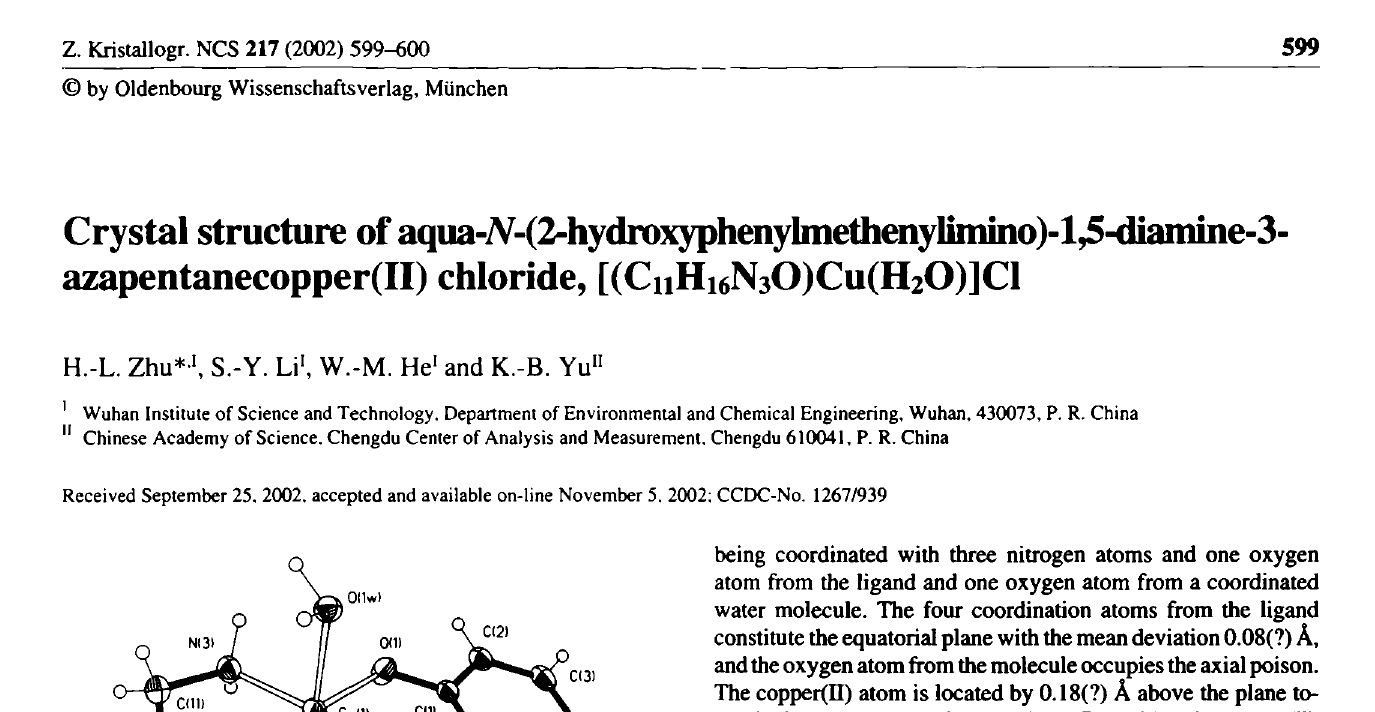
Table 1. Data collection and handling.